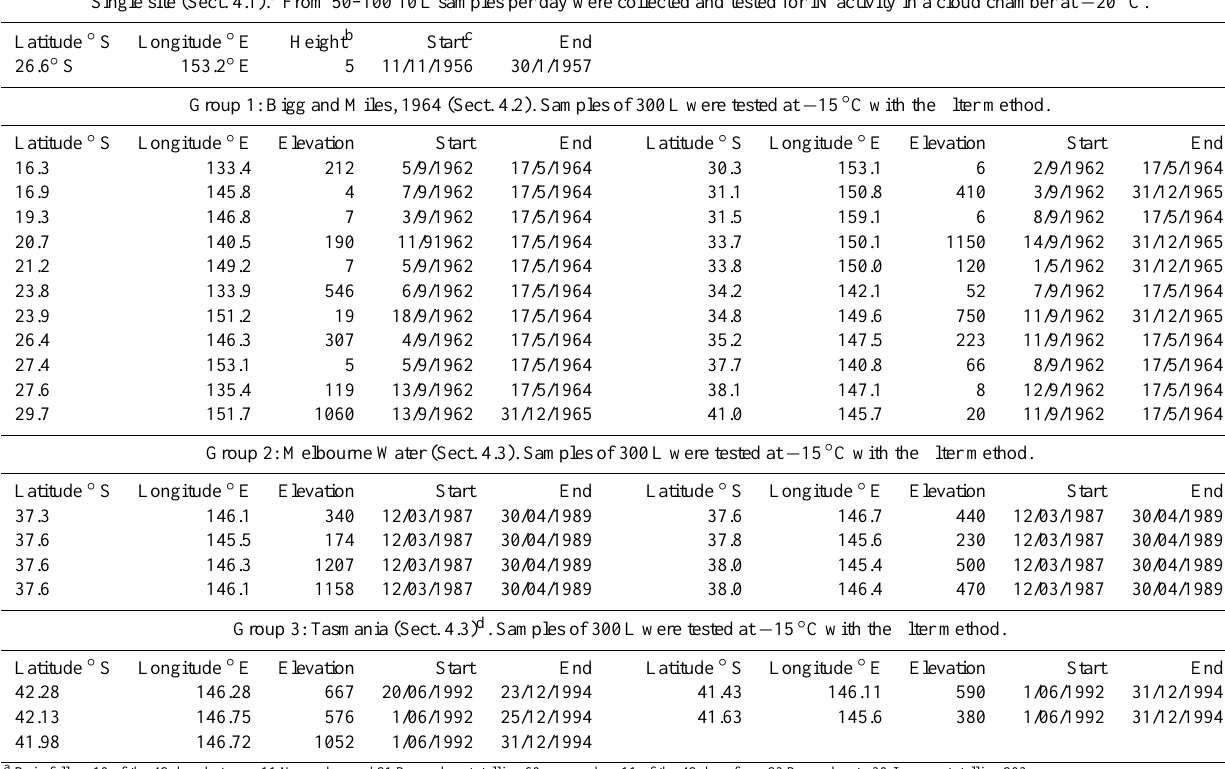
Table 1. Atmospheric ice nucleus measurement